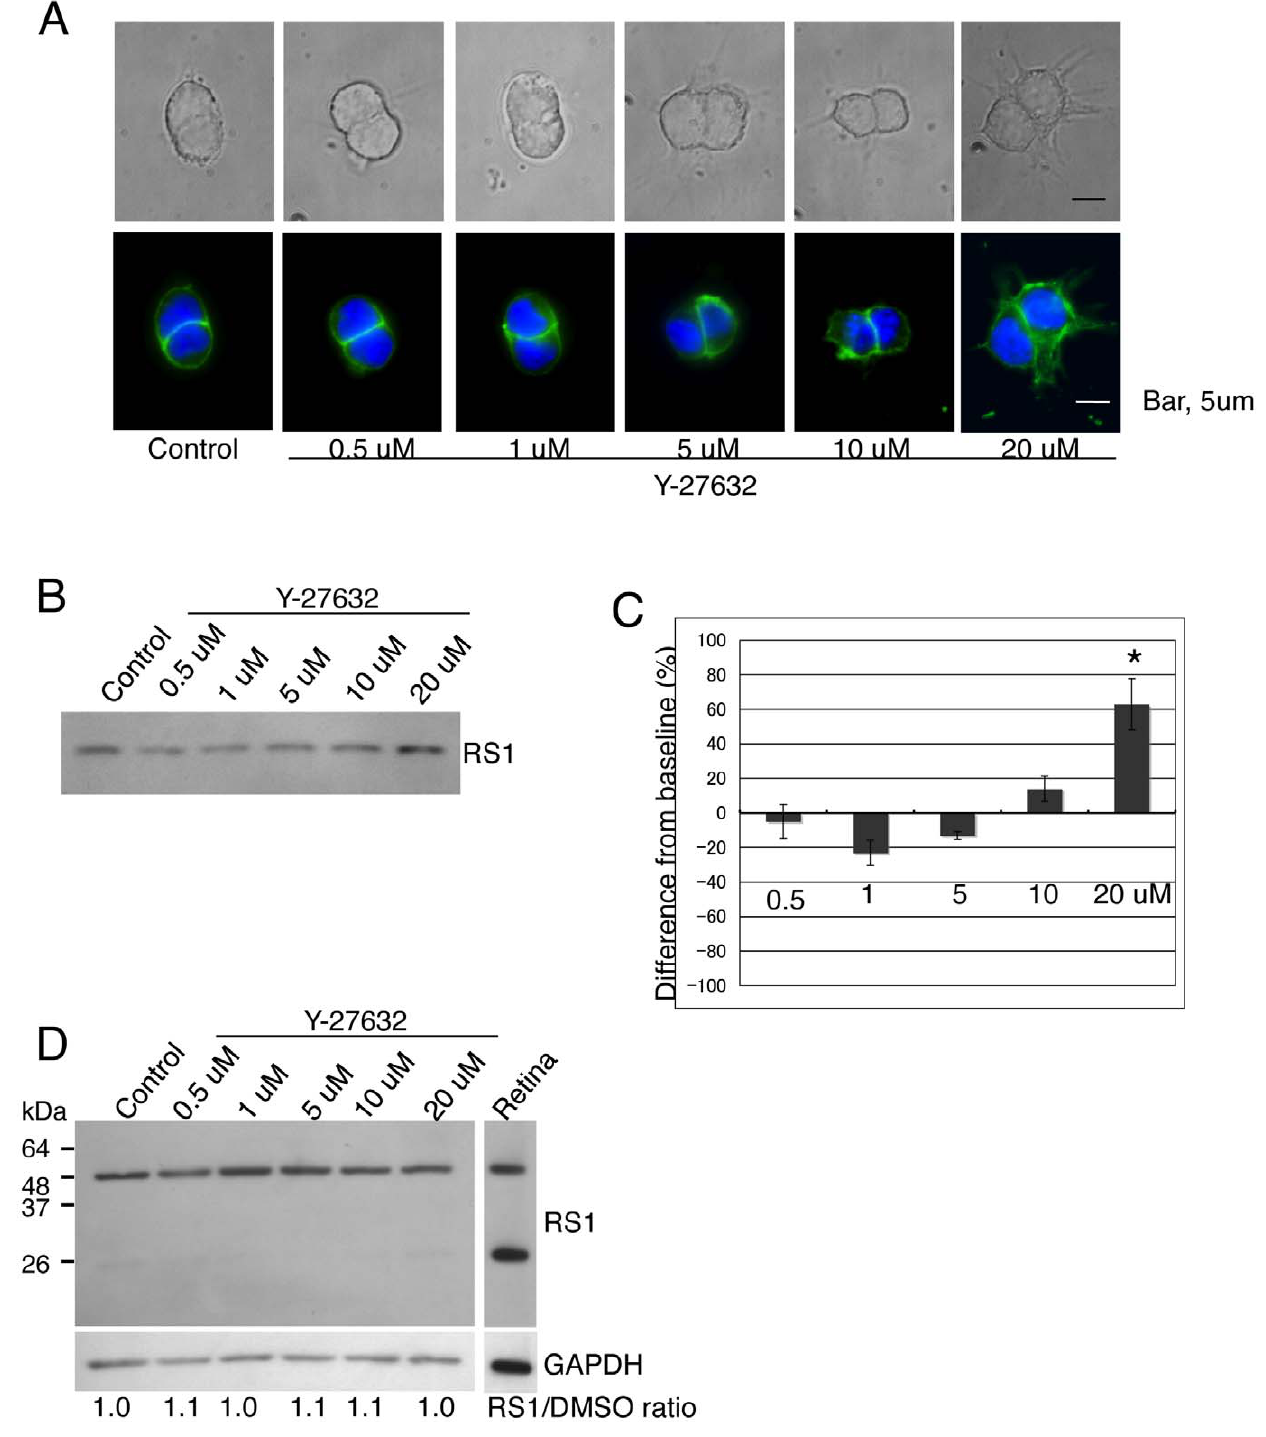
Figure 6. Retinoschisin secretion into the conditioned medium is increased by the ROCK kinase inhibitor, Y-27632. (A) Effects of Y-27632 on cell morphology and F-actin cytoskeleton organization. Weri-Rb1 cells were cultured in medium alone (untreated control) or the indicated concentrations of Y-27632 for 72 h. Cells were then fixed and labeled with Alexa Fluor 488-phalloidin (green). The upper row of pictures shows transmitted light images and the lower row, fluorescent light images. Bar, 5 m m. (B) Retinoschisin from the conditioned media of cells treated as in (A) was detected on a Western blot using the RS24-37 antibody. As seen, retinoschisin secretion into the conditioned medium is increased at 20 m M Y-27632. (C) Quantification of the intensity of each band on the Western blot from (B) (see MATERIALS AND METHODS). The data are means 6 SEM of three different biological samples for each condition. *: p , 0.05 was obtained for the difference between 20 m M Y-27632-treated and untreated cells. (D) The level of retinoschisin in the lysates of whole cells treated with the concentrations of Y-27632 used in (B) does not change. After 72 hr incubation in medium alone or medium containing the indicated concentrations of Y-27632, cells were collected and their retinoschisin was analyzed on a Western blot using the RS24-37 antibody. The band intensities of the dimer and monomer for each condition were added and normalized to GAPDH. The normalized values for treated and untreated cells were compared and are shown as RS1/control ratios. doi:10.1371/journal.pone.0020707.g006 PLoS ONE |